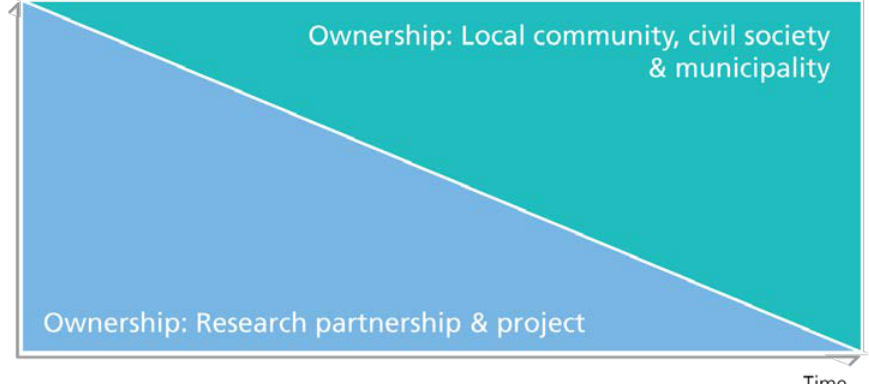
Figure 6. Illustration of the intended process towards greater local ownership of the project idea and health promoting activities.